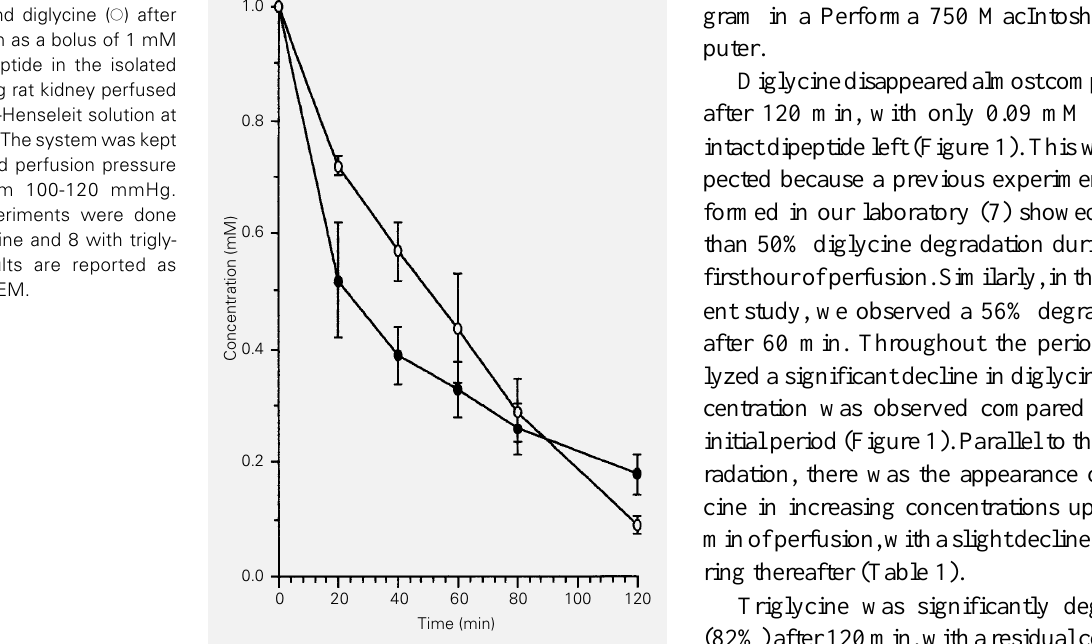
Figure 1 - Metabolism of trigly- cine ( • ) and diglycine ( ! ) after the infusion as a bolus of 1 mM of each peptide in the isolated non-filtering rat kidney perfused with Krebs-Henseleit solution at pH 7.3-7.4. The system was kept at 37 o C and perfusion pressure varied from 100-120 mmHg. Three experiments were done with diglycine and 8 with trigly- cine. Results are reported as means –